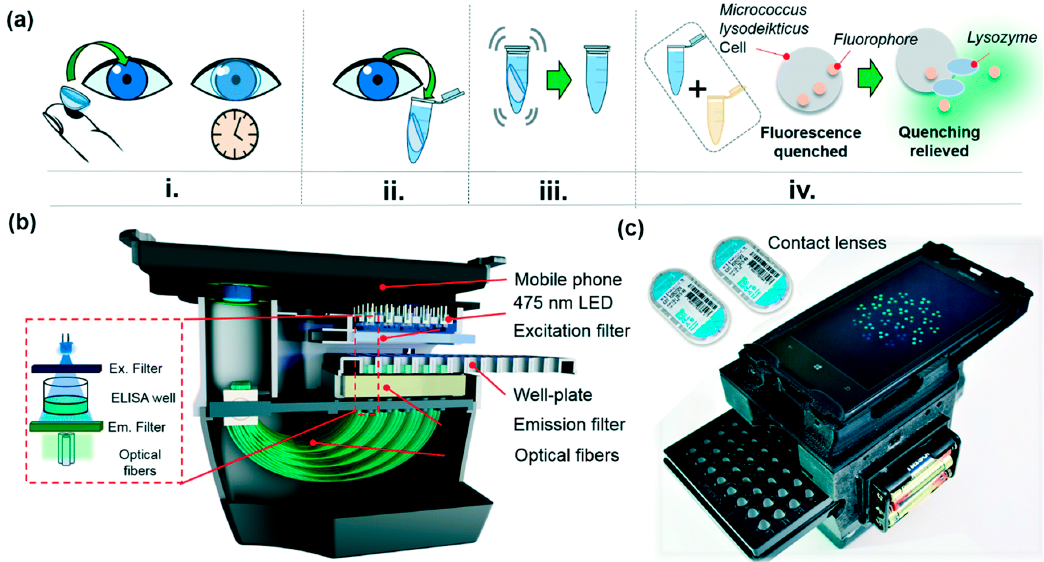
Figure 15. ( a ) (i)–(iv) Sketch: commercial contact lenses are worn for 15 min and then are removed and placed in a collection tube filled with a reaction buffer. The contact lenses are washed in the reaction tube and then are removed and discarded. Of the washed solution 100 µL is mixed with 50 µL of the fluorescent Micrococcus lysodeikticus cell solution in an ELISA well and monitored. ( b , c ) The schematic illustration of a mobile-phone based well-plate reader and a picture of some contact lens cases with the well-plate reader. Reproduced from reference [111] with permission from The Royal Society of Chemistry.